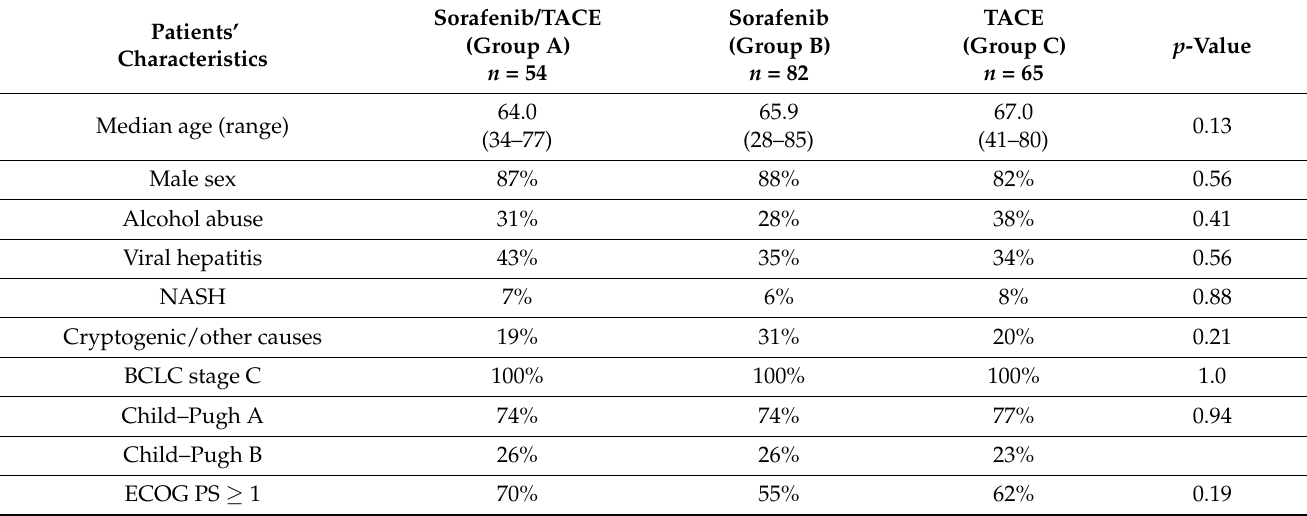
Table 1. Patient